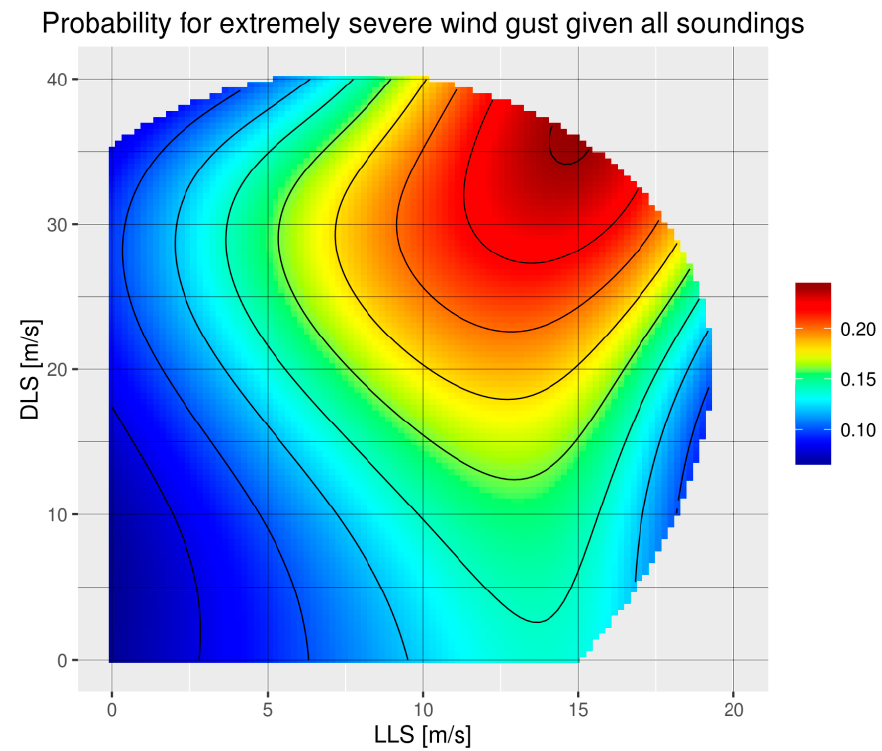
Figure 13. As in Figure 9, except for the extremely severe wind.